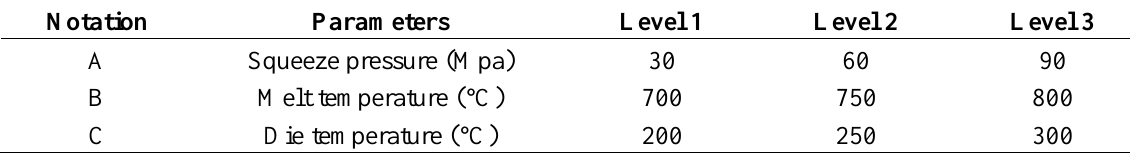
Table 7. Squeeze casting parameters and their